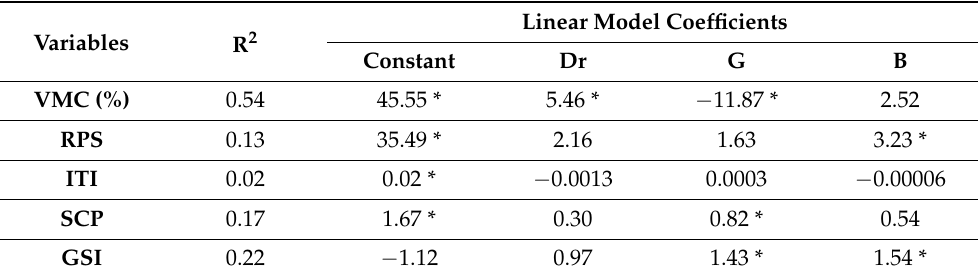
Table 4. Regression coefficients (R 2 ), and linear model coefficients for every variable VMC (%), RPS, ITI, SCP, and GSI. Significant values at p < 0.05 (*).